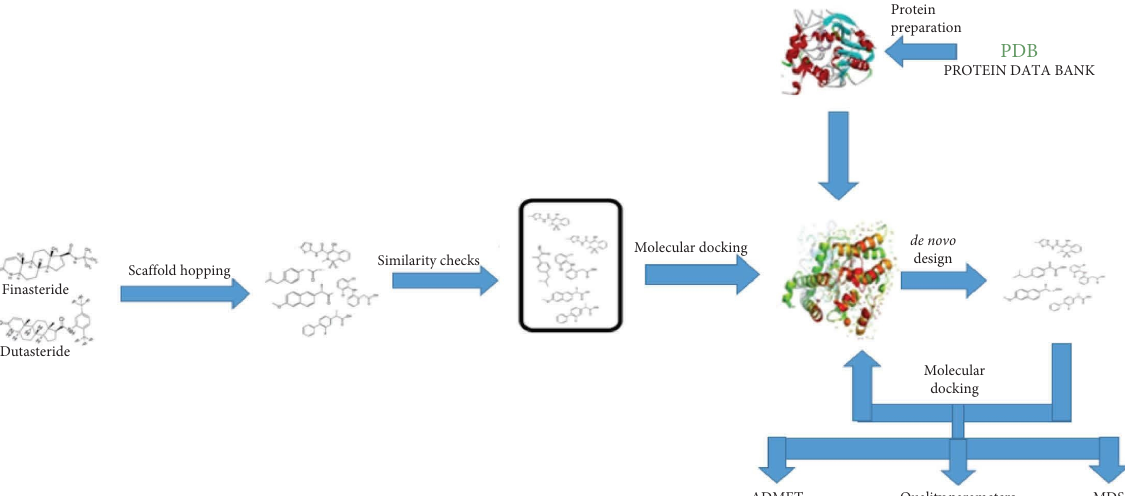
Figure 2: Detailed methodology scheme including scafold hopping, fragment-based de novo design, molecular docking, and molecular dynamics simulations in the identifcation of potential inhibitors of 5 α